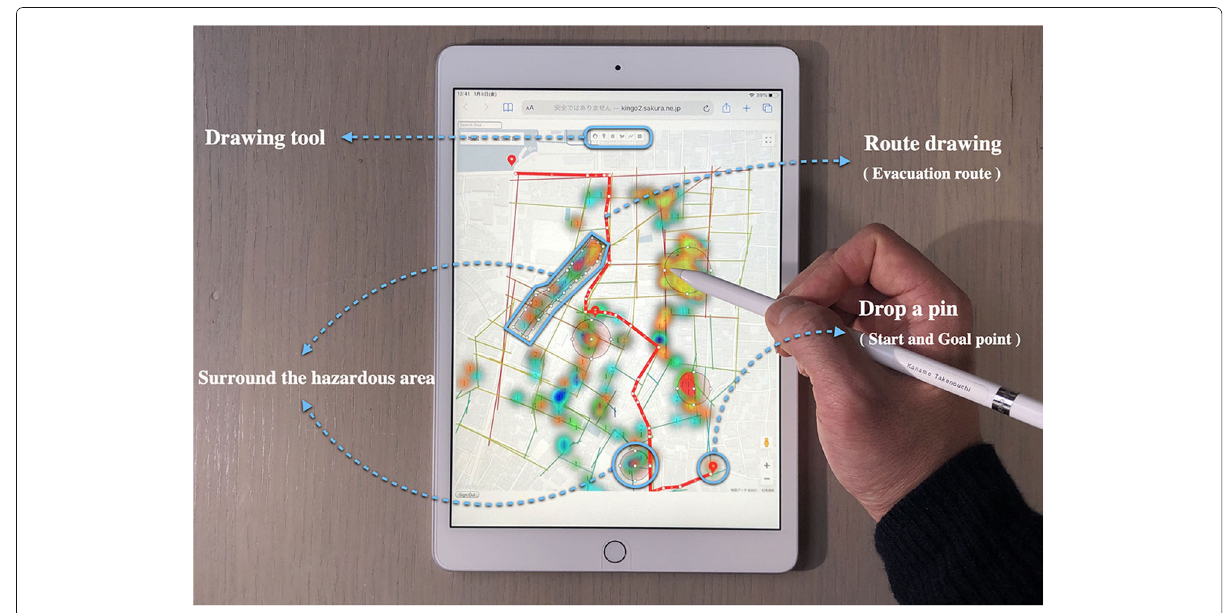
Fig. 5 Simulation of evacuation route at time of disaster